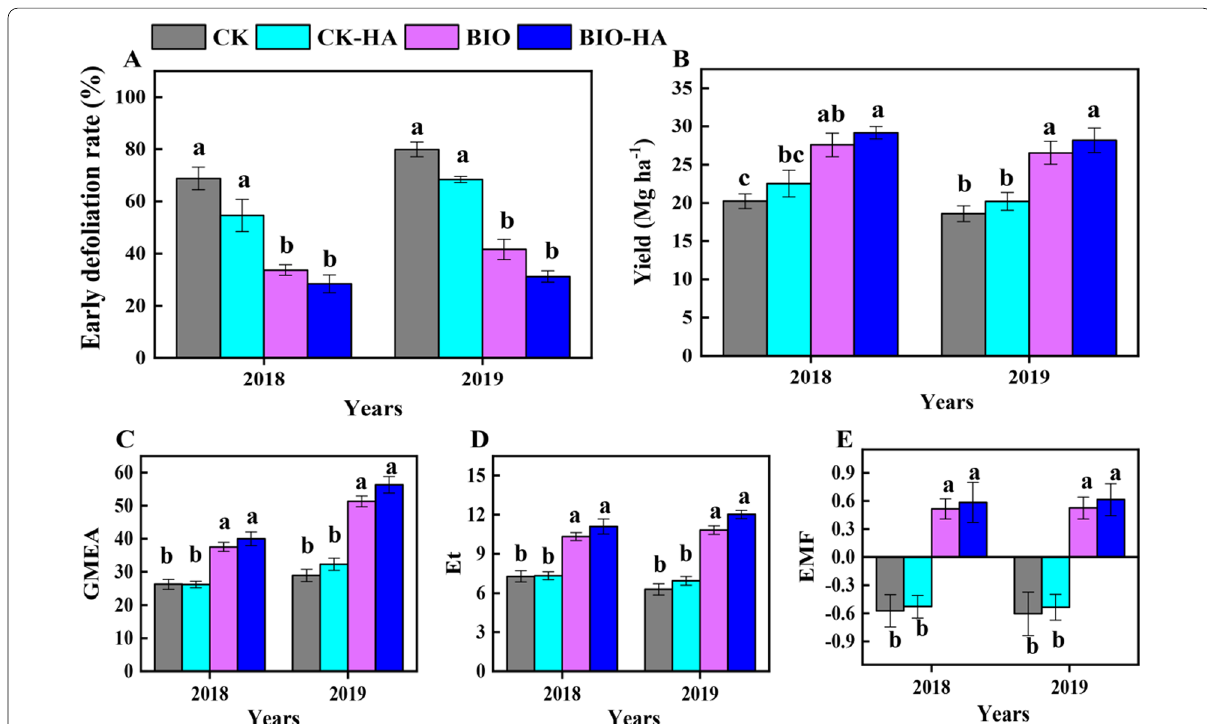
Fig. 1 Effect of organic amendments on the early defoliation rate ( A ) and yield ( B ), and geometric mean enzyme activity ( C ), total soil enzyme activity ( D ) and ecosystem multifunctionality ( E ) of pear trees in 2018 and 2019. GMEA, geometric mean enzyme activity; Et, total enzyme activity; EMF, ecosystem multifunctionality. CK, conventional fertilization; CK-HA, conventional fertilization combined with humic acid; BIO, bioorganic fertilizer; BIO-HA, combined application of BIO and HA. Different lowercase letters indicate significant difference at 0.05 levels (LSD, P < 0.05). The error bars are the standard errors (n =